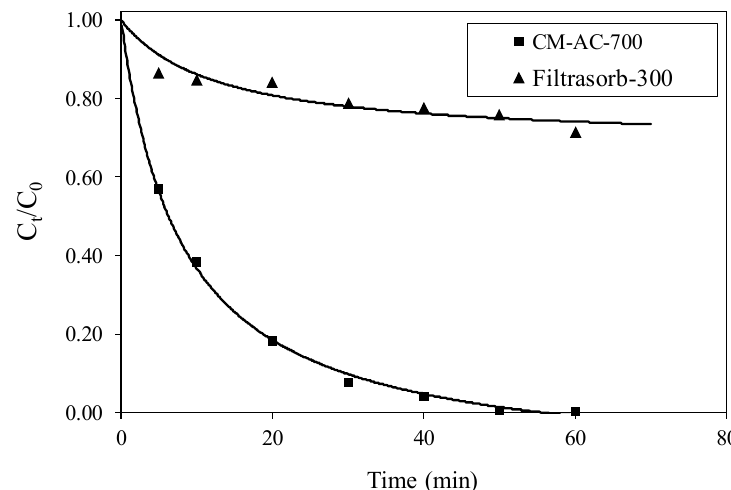
Figure 4. Effect of different ACs on MB adsorption; adsorption conditions: initial MB concentration = 10 mg/L, adsorbent dosage = 0.2 g/2 L, adsorption temperature = 25 °C, and agitation speed = 200 rpm; symbols: experimental data, full lines: calculated from Equation (1) and Table 4. Table 4. Kinetic parameters for methylene blue (MB) adsorption onto resulting AC (CM-AC-700) and commercial AC (Filtrasorb-300) based on pseudo-second order model a .